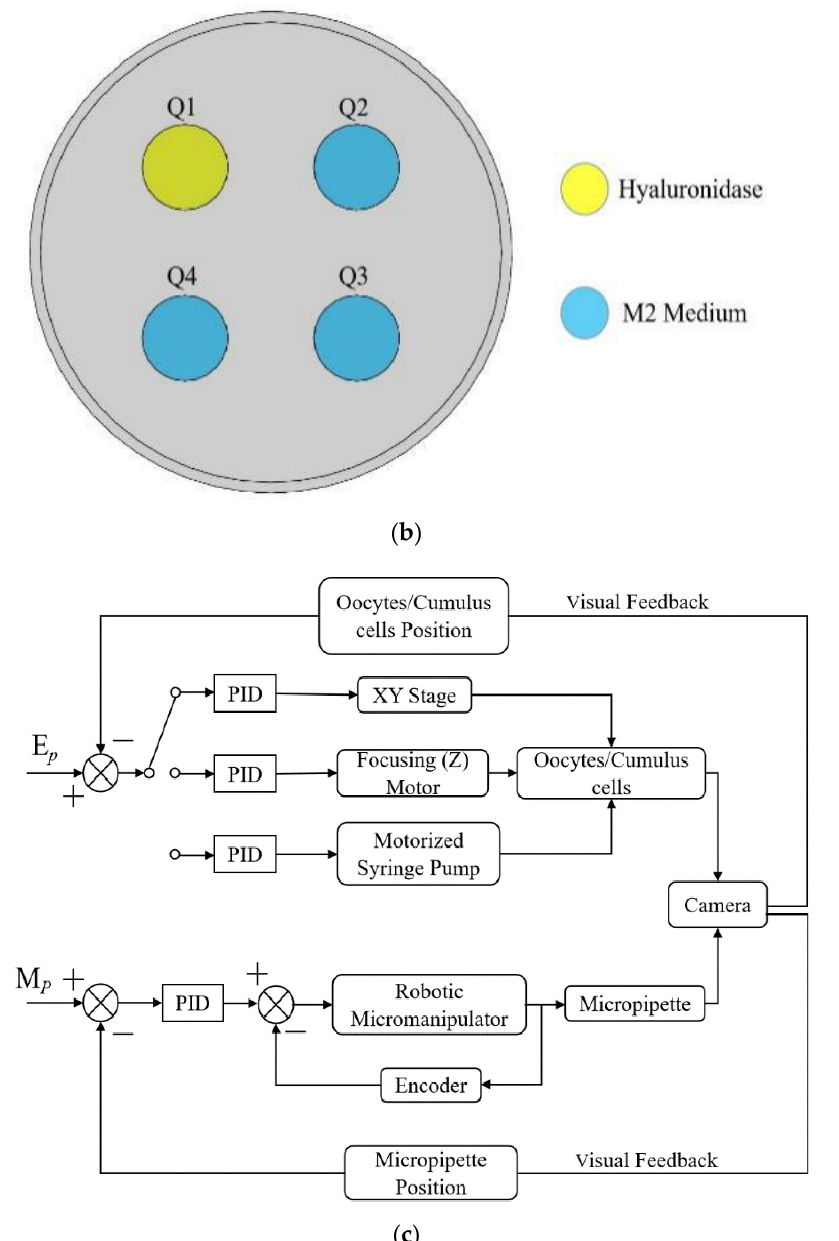
Figure 1. ( a ) Robotic denudation system setup; ( b ) Multiwell dish marked sequentially. Q1 filled with 100 μL hyaluronidase covered with mineral oil, Q2, Q3, Q4 filled with 80 μL M2 mediums covered with mineral oil; ( c ) The system control architecture. E P is the target position of oocytes and cumulus cells. M P is the target position of the micropipette tip for picking up and placing oocytes.